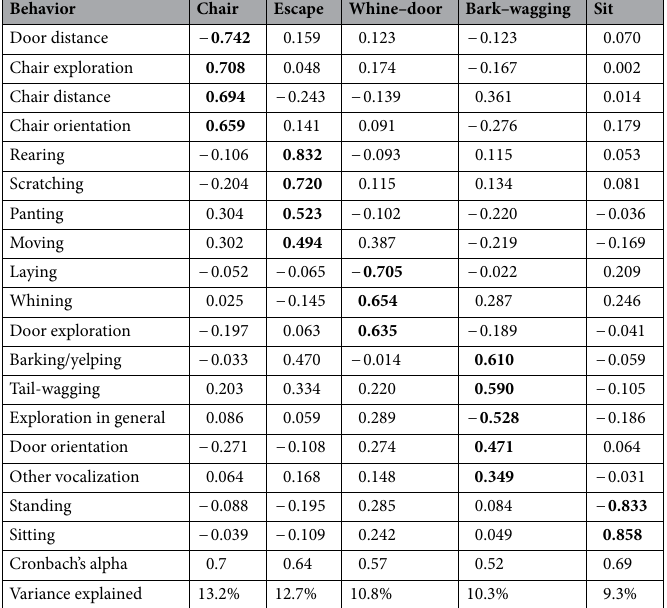
Table 2. The results of the Principal Component Analysis of the separation test (N = 167; based on Marx et al. 26 ). In case of each principal component, we highlighted the loading of those items with bold that significantly contributed to that component.